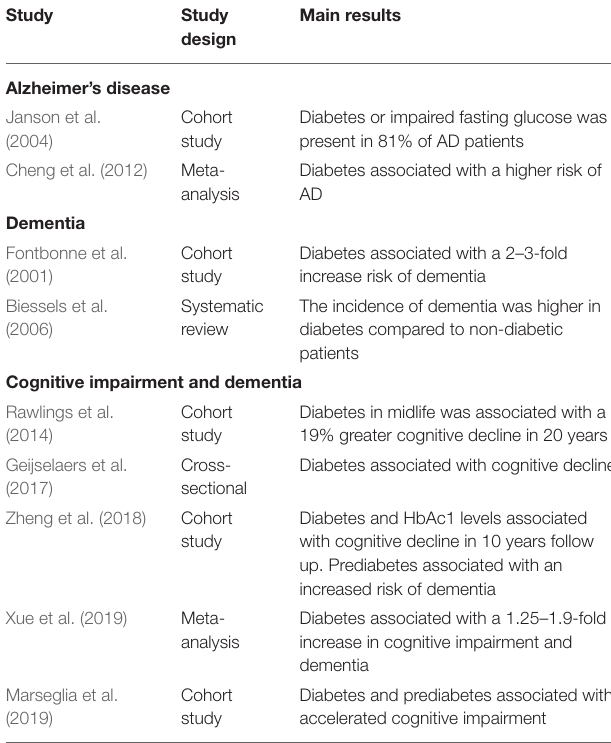
TABLE 1 | Epidemiological studies investigating the association between AD, dementia, cognitive impairment, and